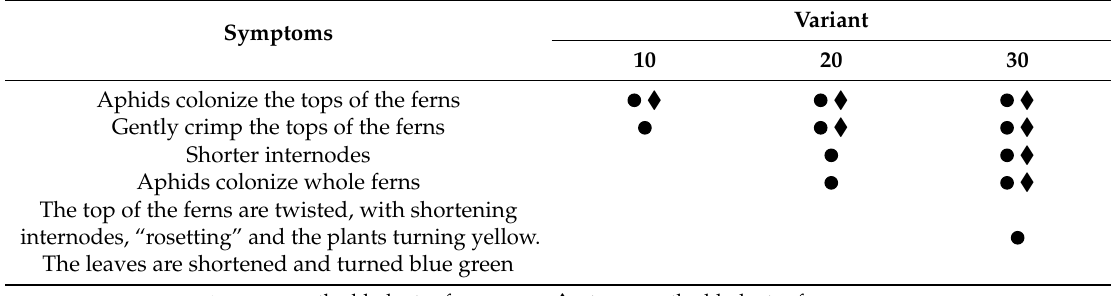
Table 1. Symptoms (96 hpi) on one- and two-month-old plants of Asparagus officinalis L. cv. Argenteuil caused by Brachycorynella asparagi (Mordvilko) at a varied population size, i.e., 10, 20, and 30 aphids per